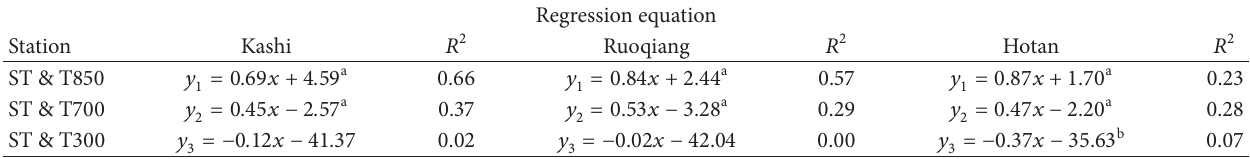
Table 4: Correlation analysis of ST and UT. Regression